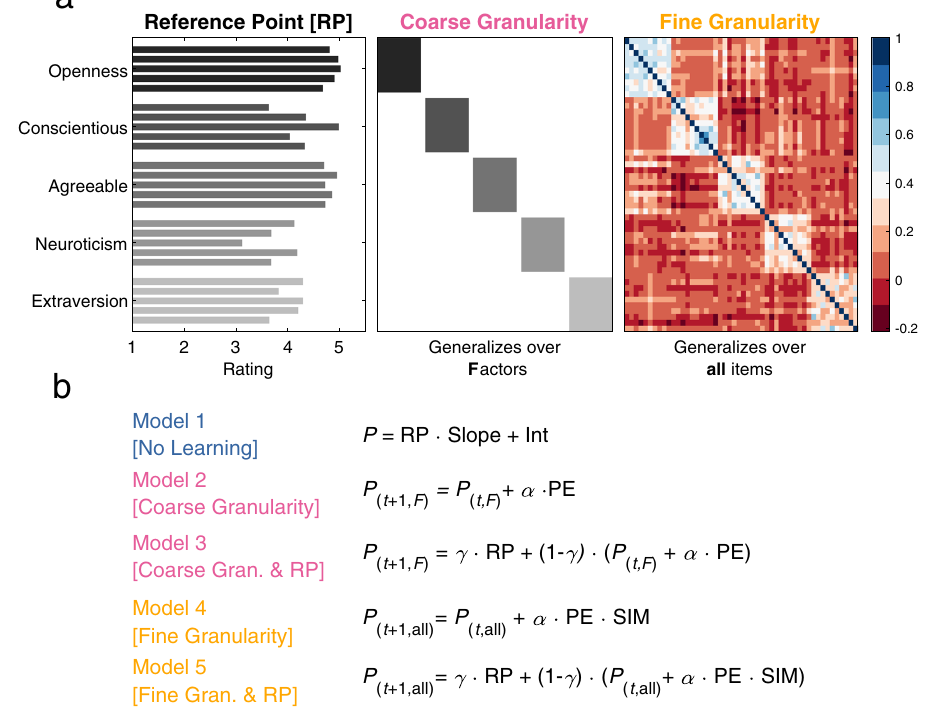
Fig. 2 | Overview of the models and knowledge structures. To explore partici- pants ’ behaviourweconstructed fi vemaincomputationalmodelsthatmadeuseof two main knowledge structures: Reference Points (RPs) and Granularity (G). a The Reference Points represent what participants can use as a basis for estimating an average person (shown is a selection of student personality trait averages). Parti- cipants can use these RPs on each trait to compare this average rating with their current estimate for a speci fi c person. Traits are ordered based on the Big-Five Factors (different shades of grey).Granularity(G) refers to the level ofdetail inthe represented structure of others ’ personality traits. The granularity matrix gen- eralizes the PEs across similar items in two distinct ways: for coarse granularity it generalizes per Big-Five factor, and for fi ne granularity it updates every individual trait based on how correlated they are to the current trait. b Using both RPs and granularity the models can be divided into three sets, which are depicted in three